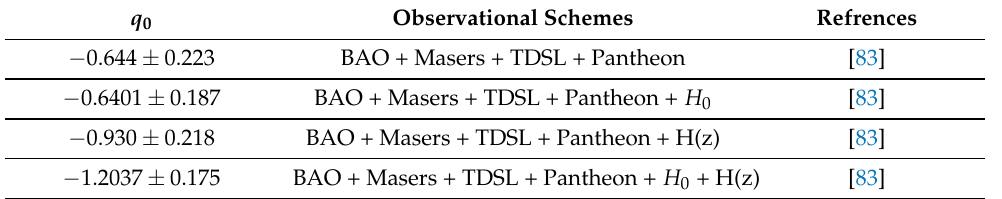
Table 4. Summary of the observational data on q 0